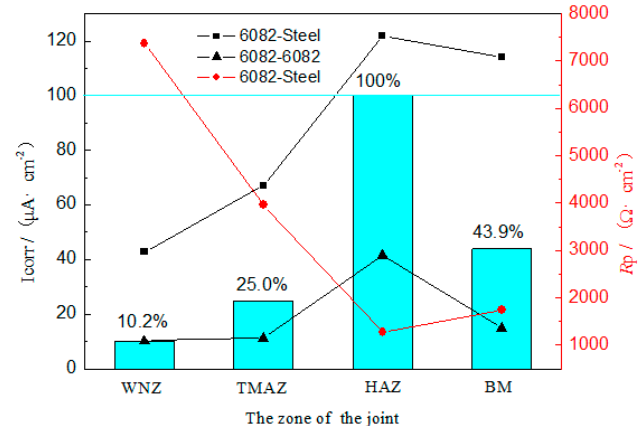
Figure 12. The curves of R p value and self-corrosion current density, and the histogram of the relative corrosion rates of different areas of the transverse section of keyhole-free FSSW joints in 3.5% NaCl solution.